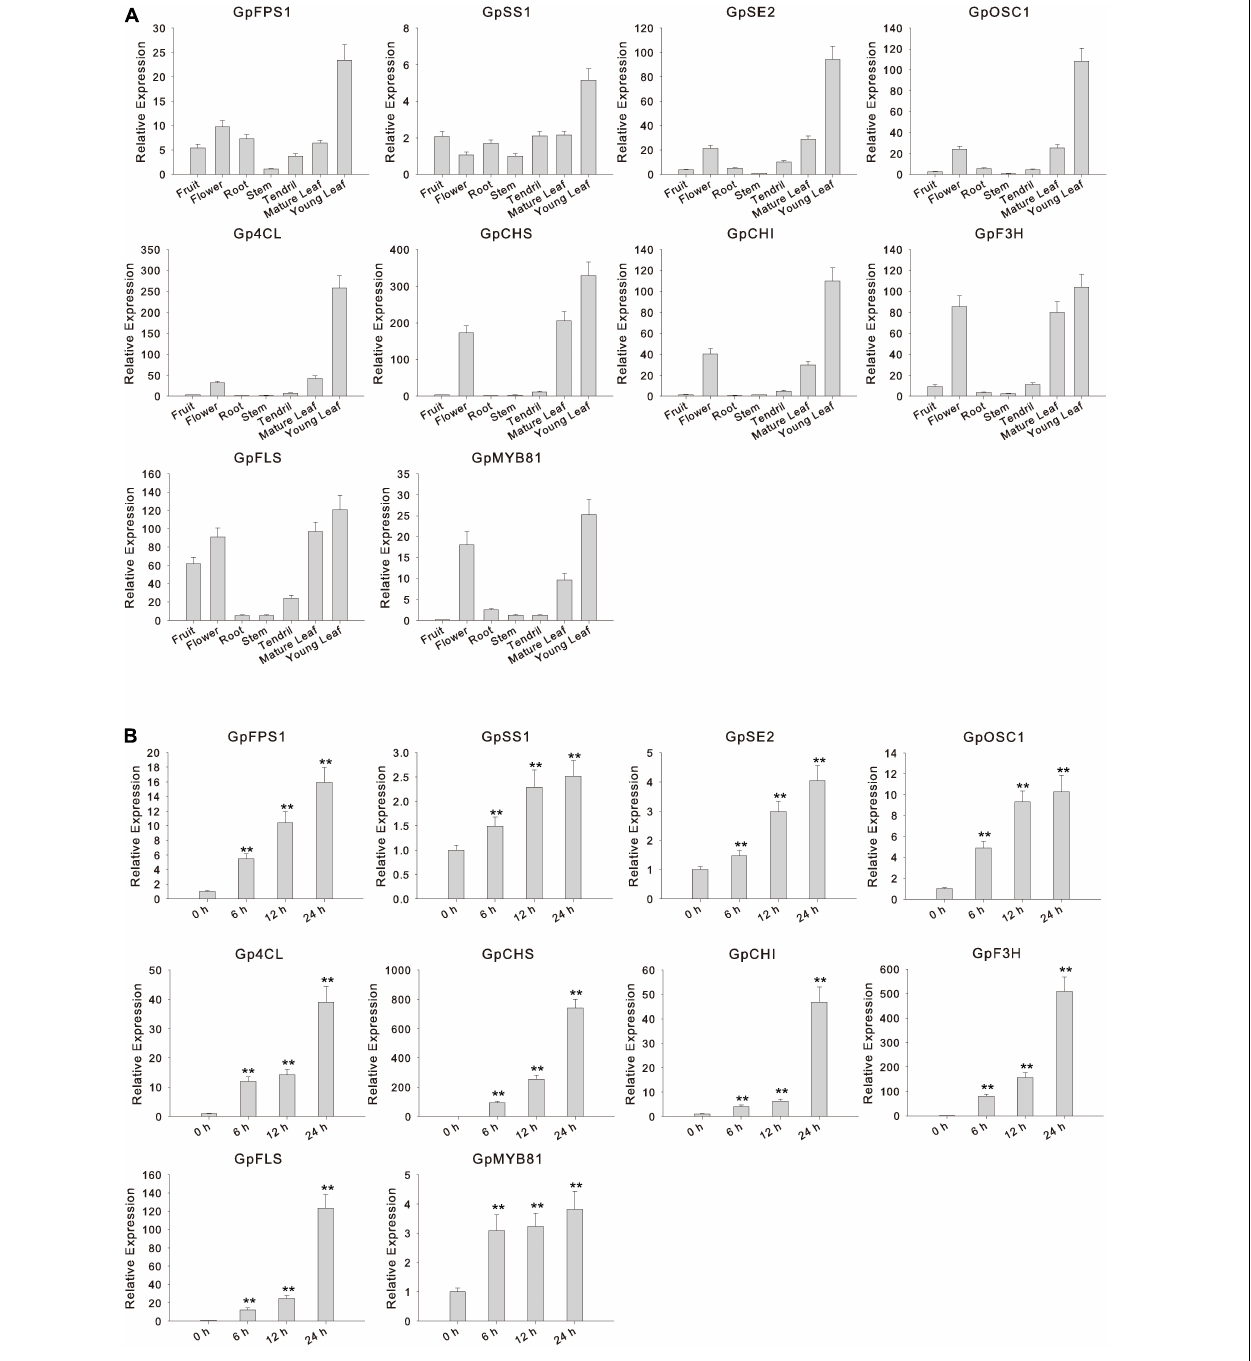
FIGURE 6 | Expression profile of 10 selected candidate genes in different tissues and response to methyl jasmonate (MeJA) treatment. (A) Expression analysis of gypenoside and flavonol biosynthetic genes and candidate regulator GpMYB81 in different tissues of G. pentaphyllum . Values represent the mean ± SE ( n = 3 biological replicates). (B) Expression analysis of gypenoside and flavonol biosynthetic genes and candidate regulator GpMYB81 with 0 (negative control), 6, 12, and 24 h treatment with MeJA. ** p < 0.01 (two-tailed Student’s t -test). Values represent the mean ± SE ( n = 3 biological